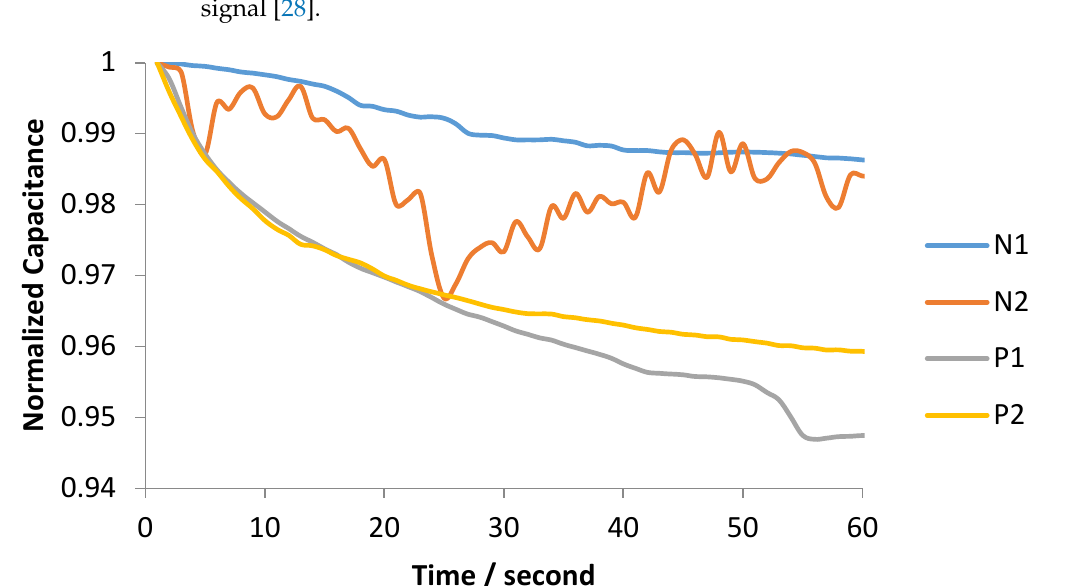
Figure 6. Normalized capacitance change over time for S protein.